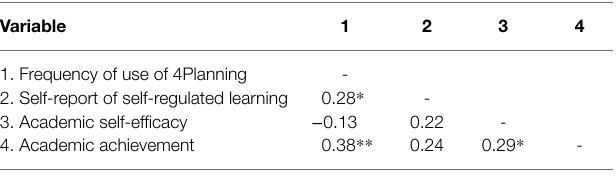
TABLE 3 | Spearman’s correlation coefficient between the study variables in the post-test in the experimental group.